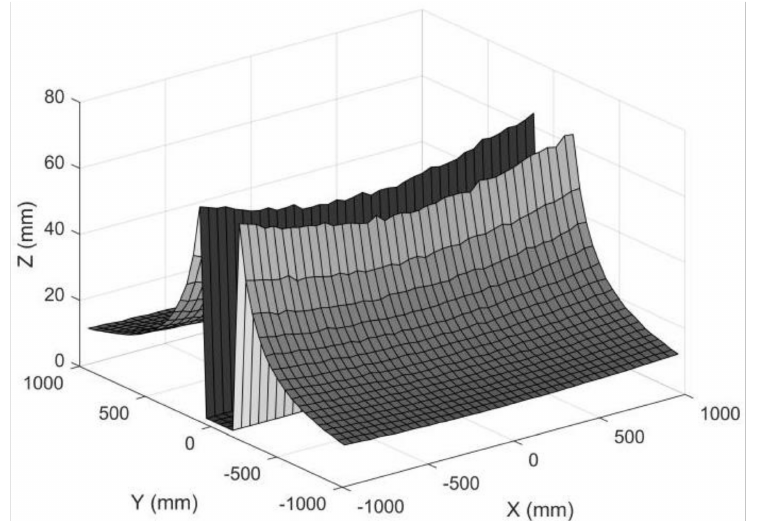
Figure 17. Standard deviation for object points in a plane. The standard deviations for object points with small Y C coordinates were removed for large reconstruction errors. The standard deviation of the pixel position was 0.2 pixels, the ad was 30 mm, and the Z C was 1500